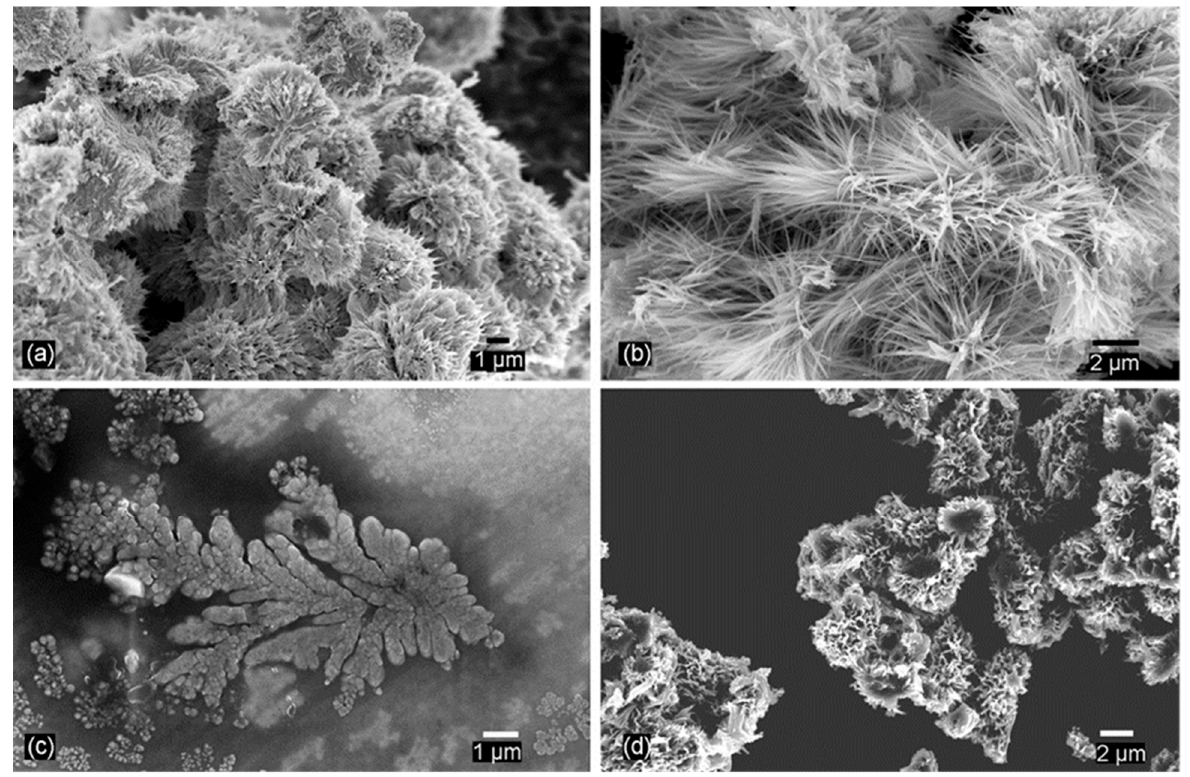
Figure 2. SEM images of TiO 2 dendritic nanostructures prepared via sol-gel reactions of titanium isopropoxide with acetic acid in scCO 2 ( a , b ) and isopropanol ( c , d ).